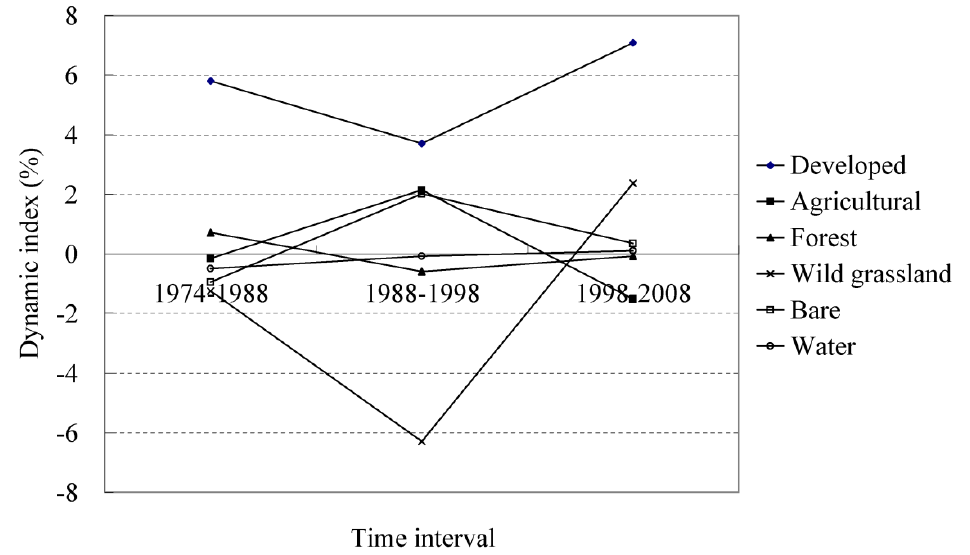
Figure 3. Dynamic index of land-use/land-cover at the class